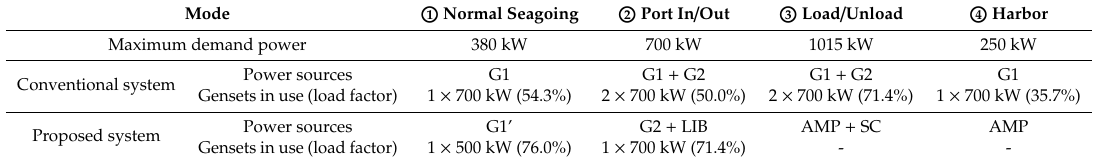
Table 2. Comparison of power demands between a conventional and the proposed